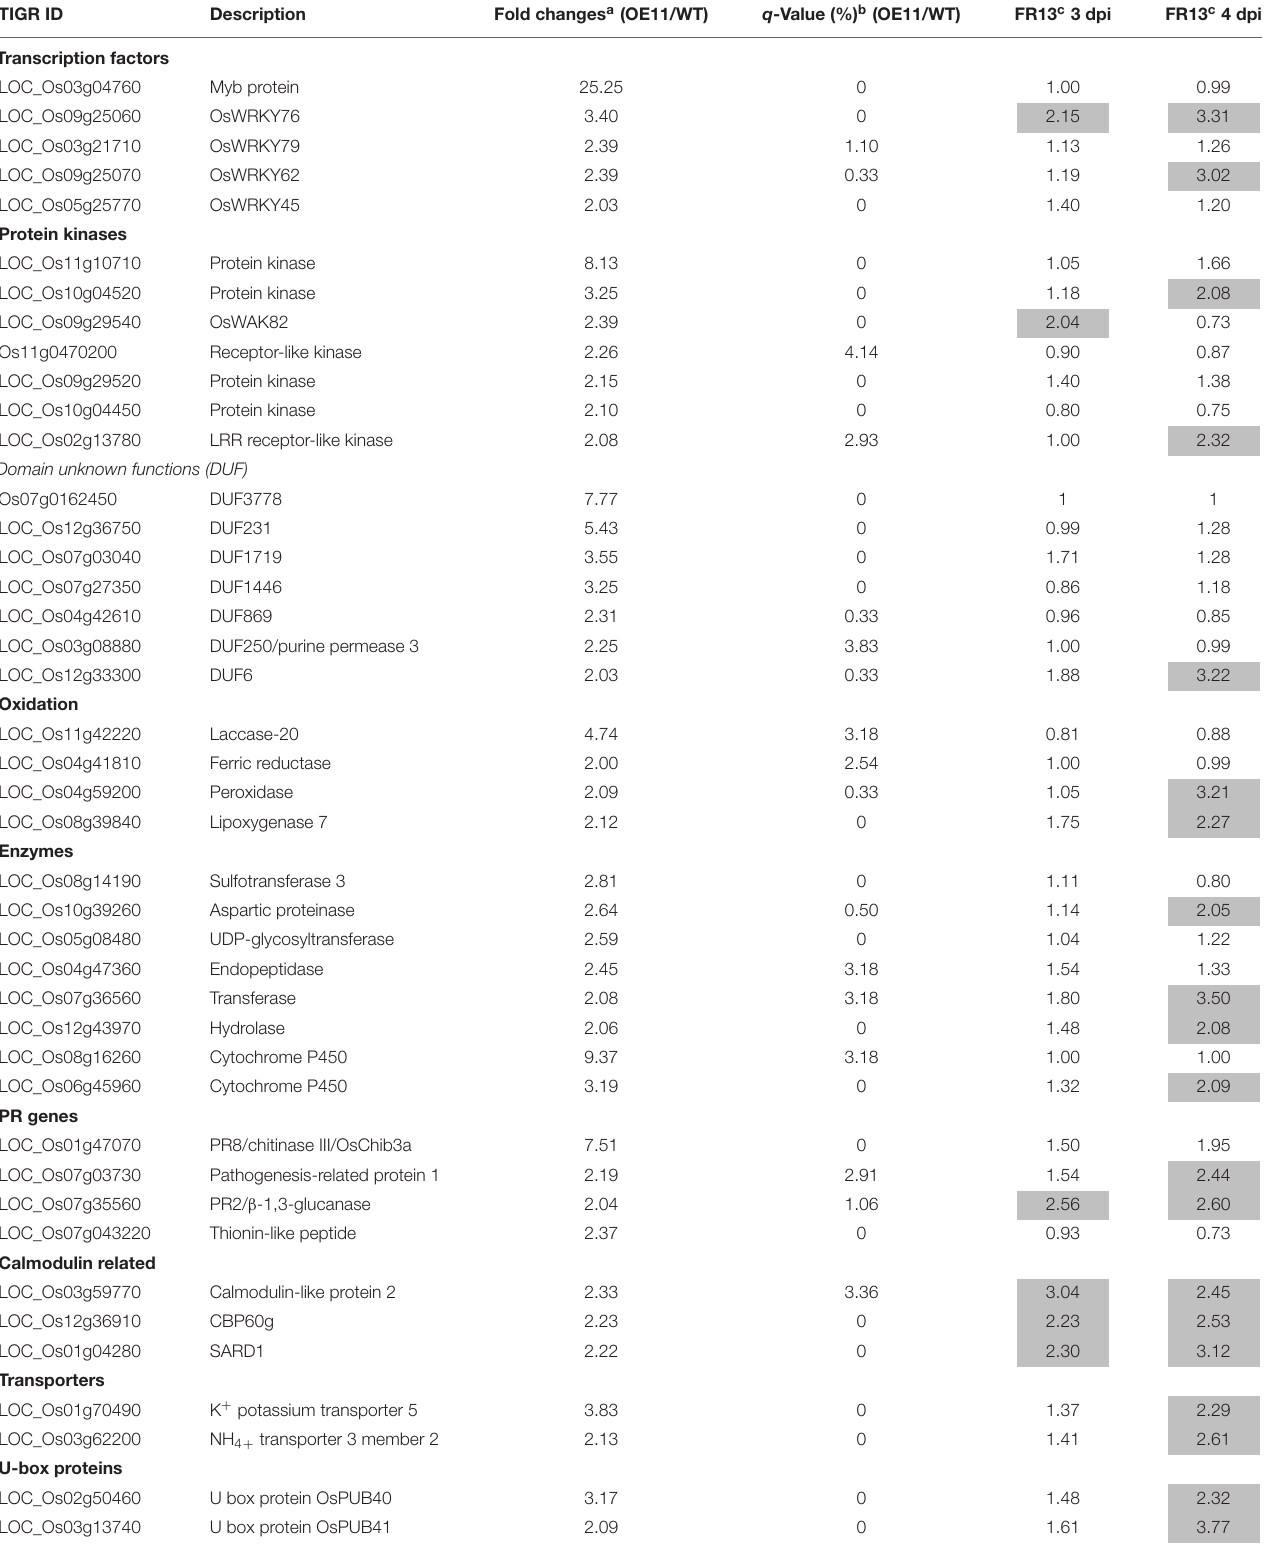
TABLE 1 | Up-regulated genes in ONAC066-OE11 plants. TIGR ID